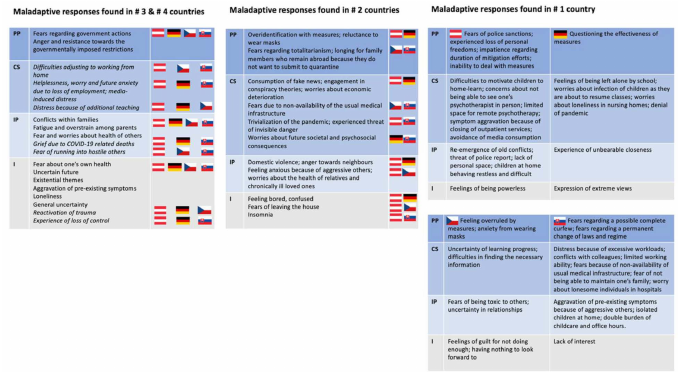
Figure 4. Maladaptive responses that could potentially deteriorate a patient’s health state were found in #4 and #3 countries, #2 countries, and #1 country.